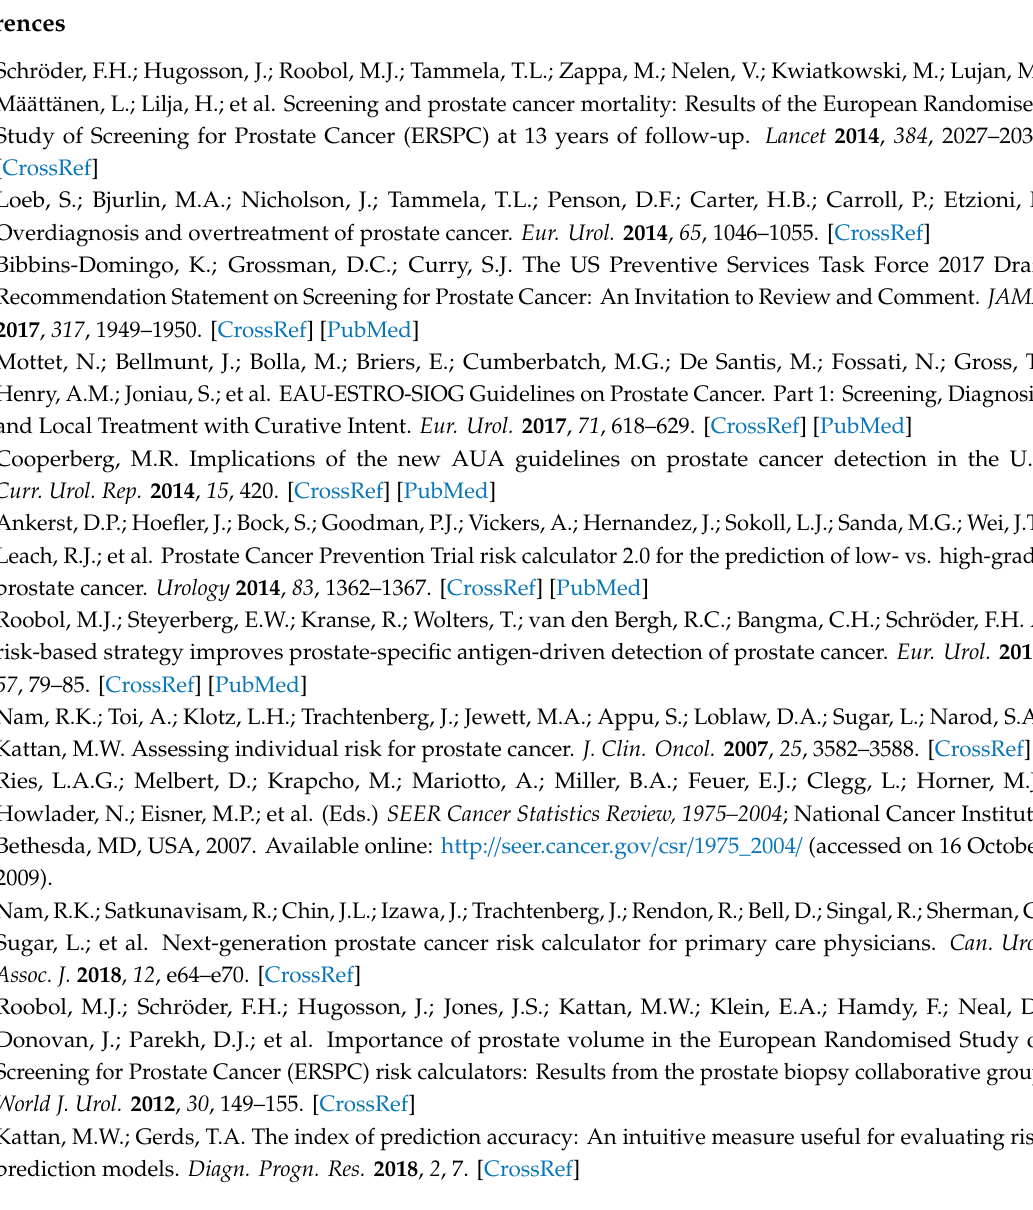
Figure S1: Decision curve analysis for di ff erent prediction models incorporating prostate measurements, Table S1: Clinical impact of the three prostate cancer risk calculators, Table S2: Characteristics of 19,247 men from the screening arm of the ERSPC section Rotterdam stratified to alive and death during the period 1993–2013, Table S3: Characteristics of the ERSCP screenings arm vs. the Dutch general